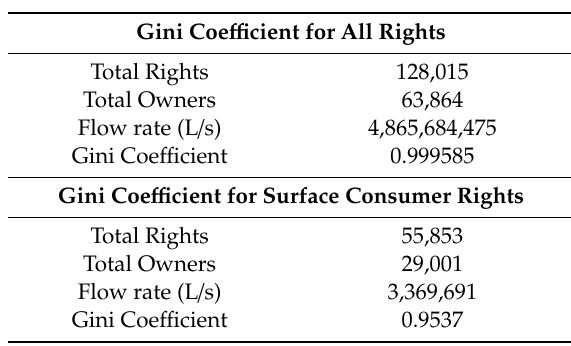
Table 4. Study of the Gini Coe ffi cient at the national level for the total and specific superficial consumer rights. Source: Prepared by the authors.